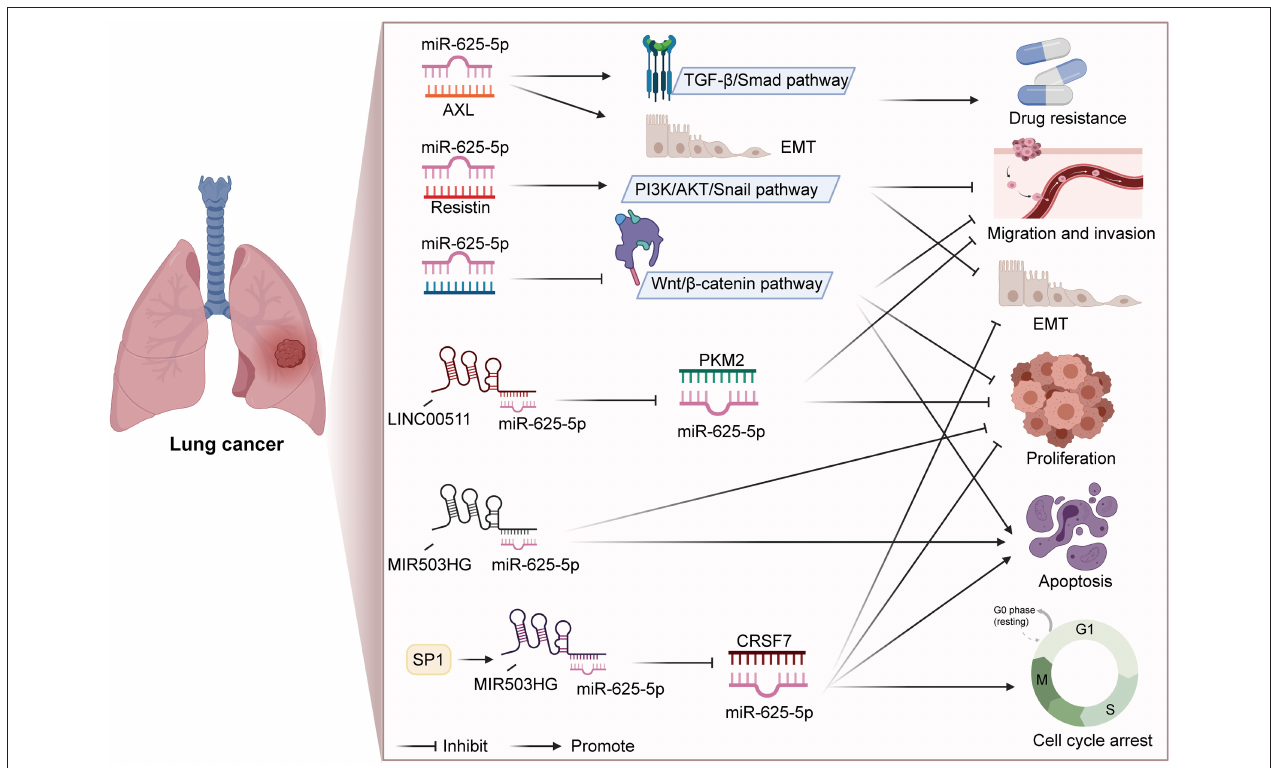
FIGURE 1 | Summary diagram of the roles and mechanisms of miR-625 in lung cancer (Created with BioRender.com).